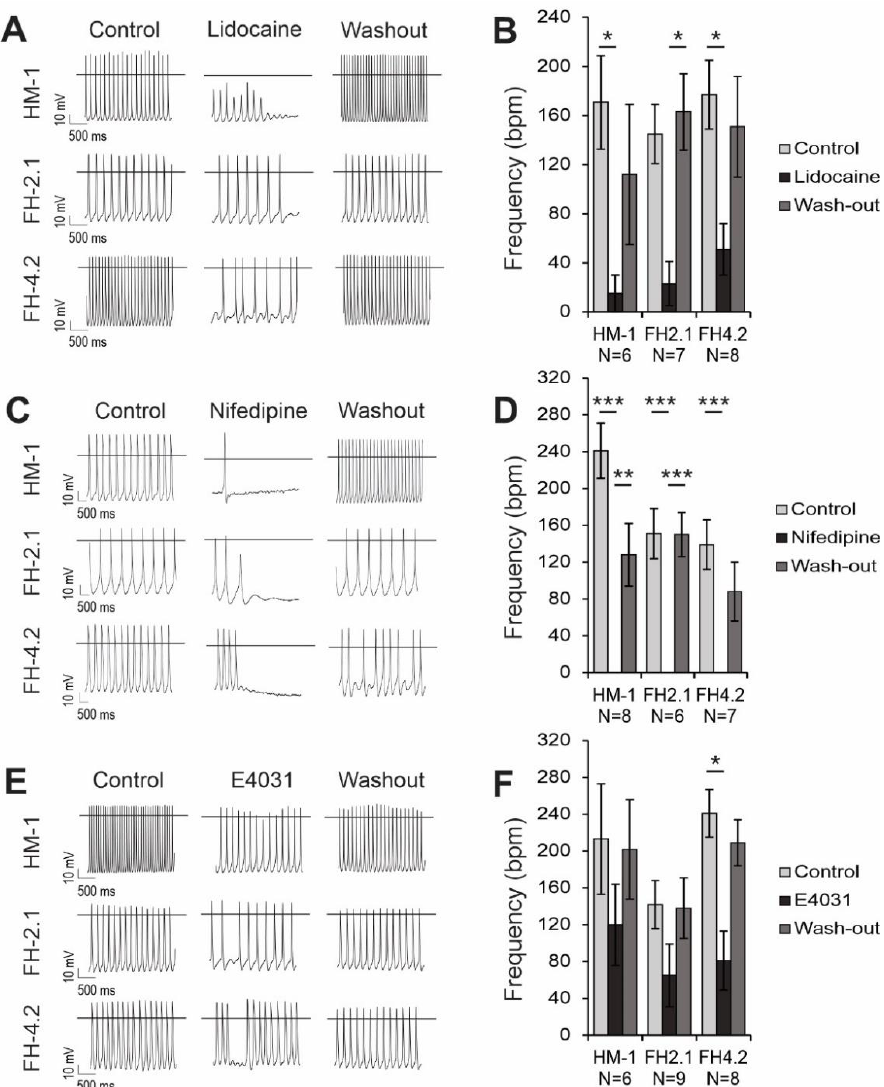
Figure 7. Effect of lidocaine, nifedipine, and E4031 on ESC- and FH-PSC-derived CMs. ( A , C , E ) APs were recorded before the application of drugs (Control), in the presence of 30 µ M lidocaine, 1 µ M nifedipine, or 0.25 µ M E4031, and after washout of drugs (washout). Representative traces are shown. ( B , D , F ) Statistical evaluation of the drug effect on beating frequency in HM-1 ESC-CMs, FH-2.1 CMs, and FH-4.2 CMs. Data are presented as the mean ± SEM. N indicates the number of cells analyzed. Statistical analysis was performed by one-way ANOVA followed by the post hoc Bonferroni’s test. p -values are only given for group comparisons with statistically significant differences. * p <